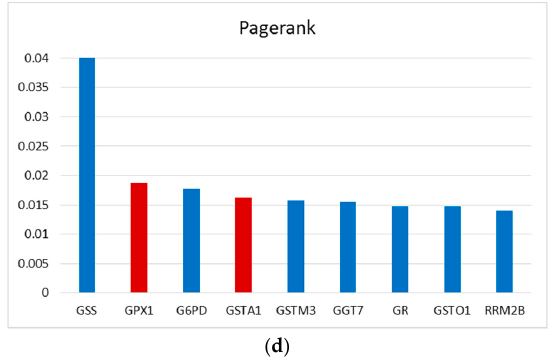
Figure 3. Network analysis of GSTA1 and GPX1 targets pattern. ( a ) protein-protein interaction (PPI) network constructed by 44 enzymes in GSH metabolism; ( b – d ) measurements of proteins in network, blue represents the proteases in GSH metabolism; red represents GSTA1 and GPX1.